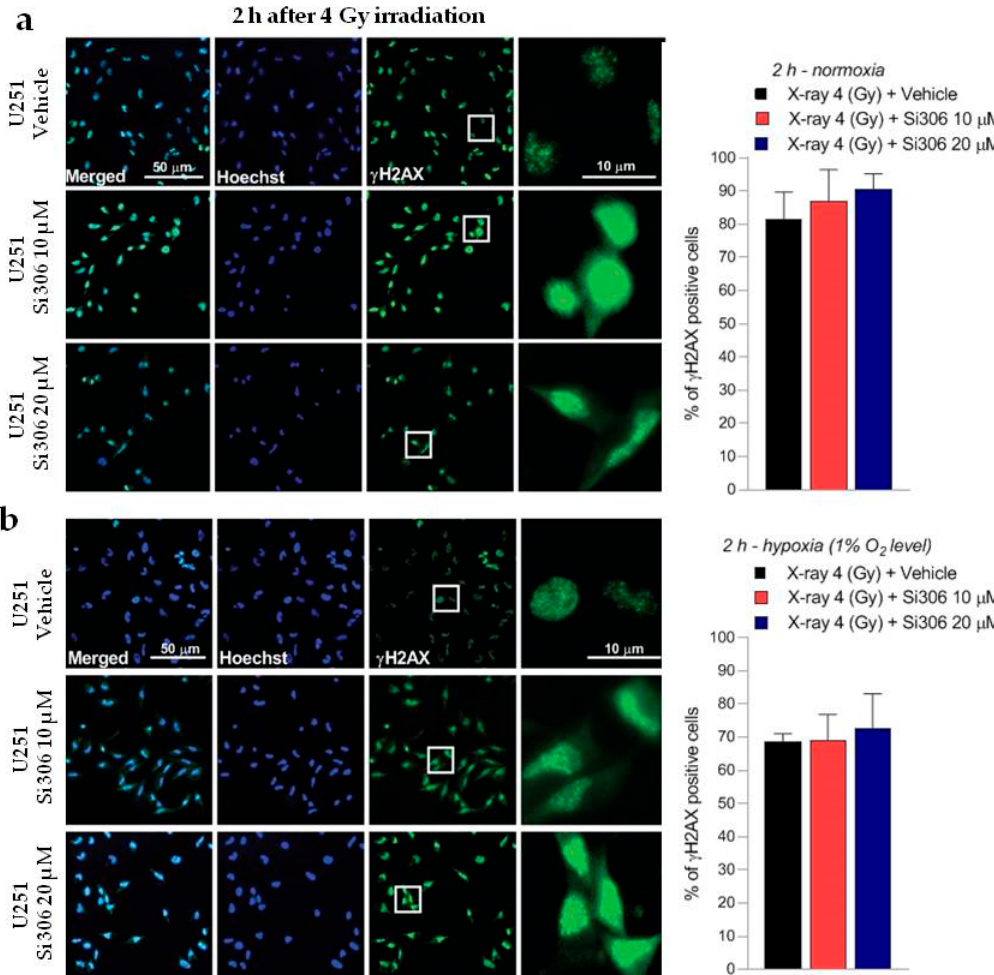
Figure 5. Representative pictures with inserts (white squares) and quantification of U251-MG positive cells for γ H2AX performed 2 h after 4 Gy irradiation in normoxia (a) and hypoxia (b) . Data are mean ± SD of n = 3 independent experiments; *** p -value < 0.001 and **** p -value < 0.0001 versus 4 Gy + vehicle; (F normoxia = 2.030, p -value = 0.1564; F hypoxia = 0.5685, p -value = 0.5798. One-way ANOVA with Holm–Šídák post-hoc test).